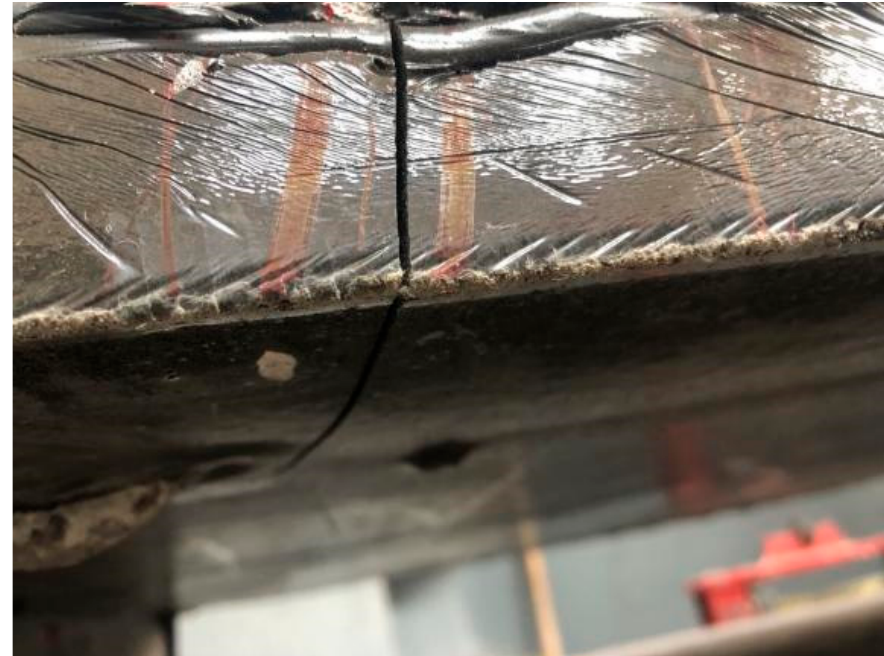
Figure 9. Fracture of L1 polyurethane.